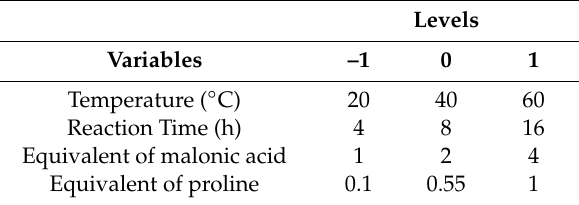
Table 1. Parameters and their variation corresponding to defined levels of the DoE.